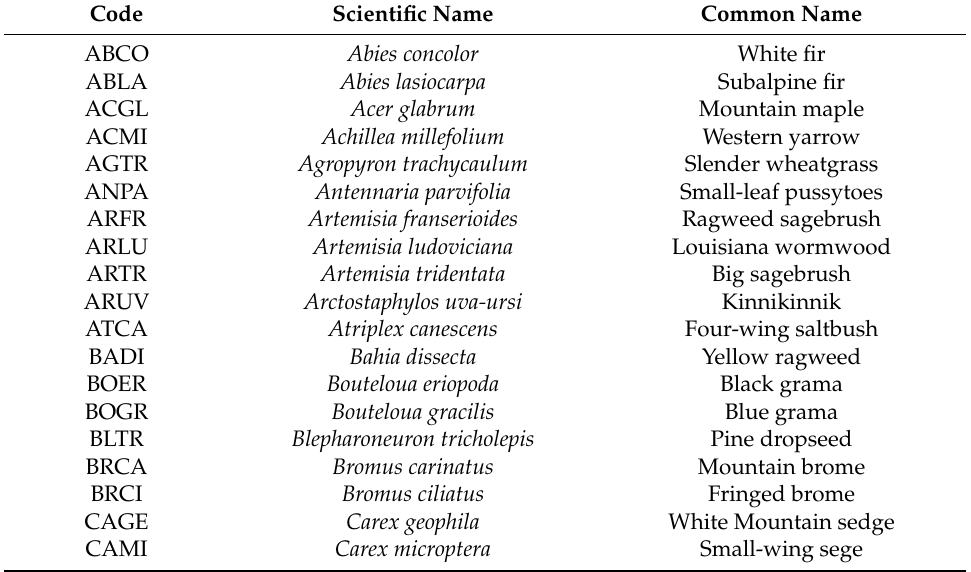
Table A1. Plant species that are common in land cover classes of the Jemez Mountains in northern New